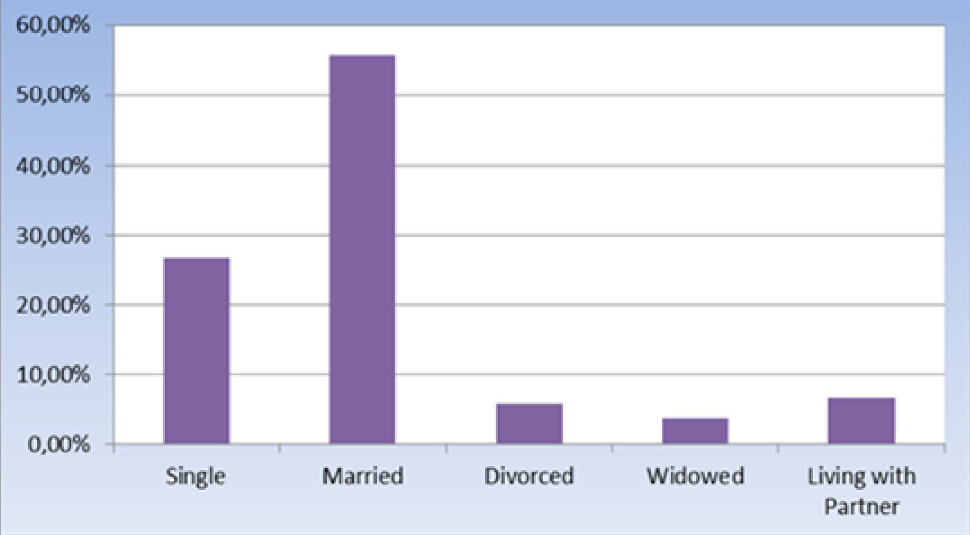
Figure 1: Marital status of respondents